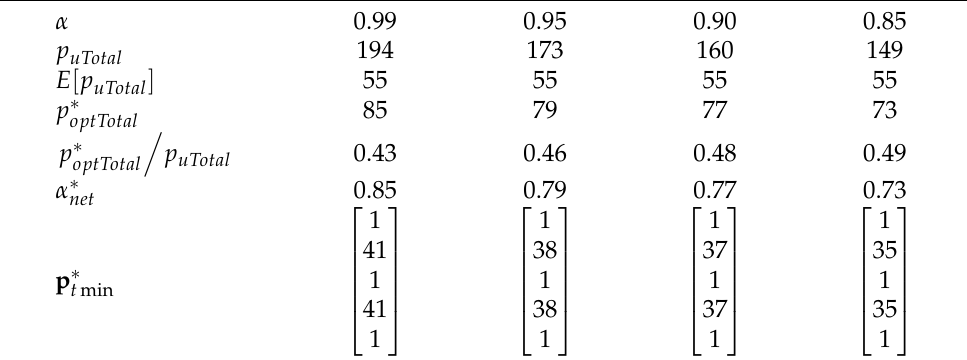
Table 3. Comparison of optimization results of power allocation